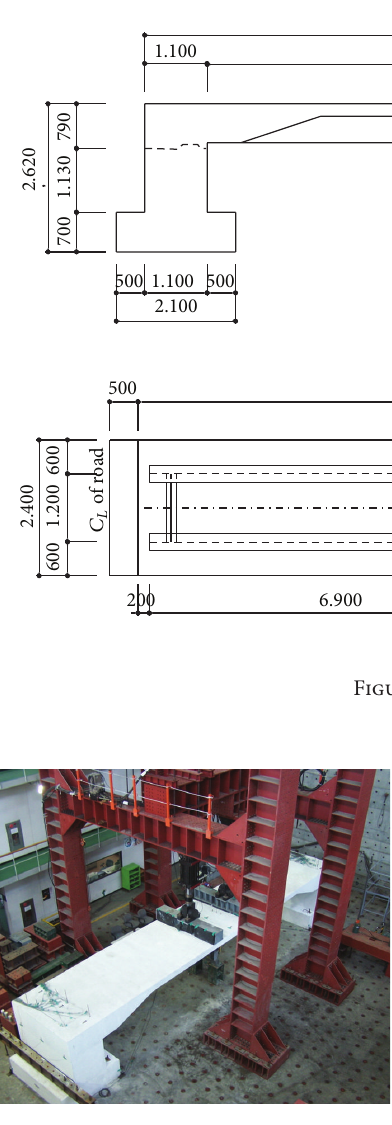
Figure 3: Photograph of test